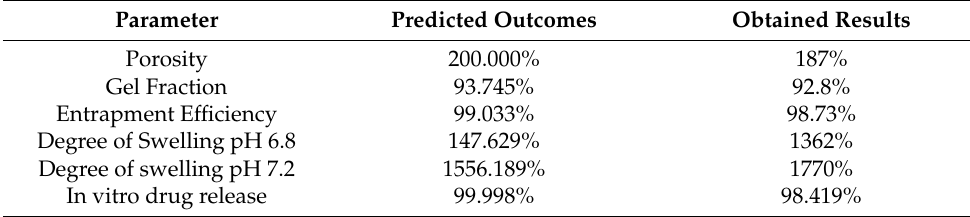
Table 4. Comparison of the predicted outcomes and obtained results of β -CD hydrogels.